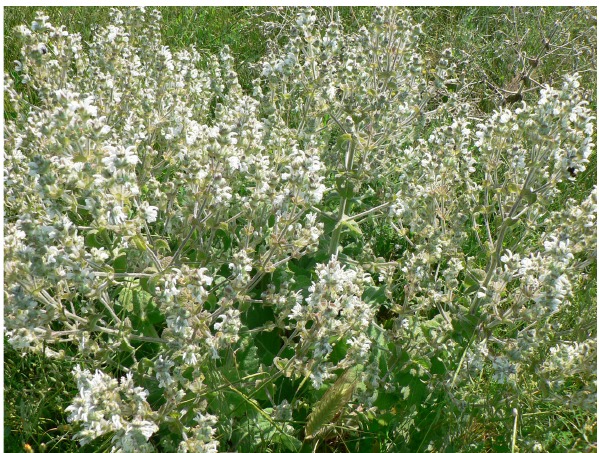
Fig. 3. Salvia aethiopis in the grasslands located at the periphery of Radovan settlement (original)